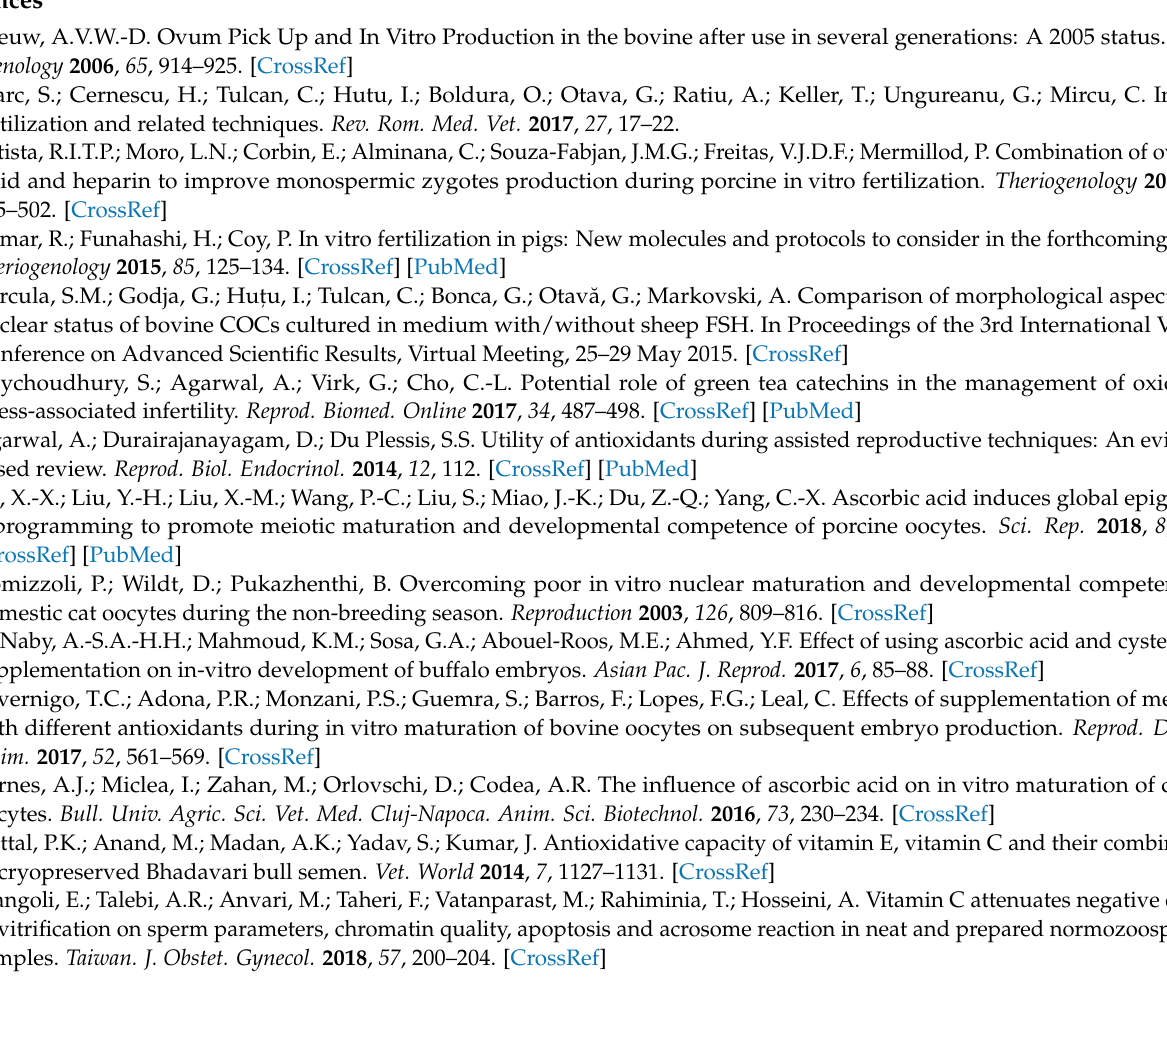
Figure A3. Aspects of porcine oocytes from ascorbic acid group (A) classified according to their morphological aspects before and after IVM. Scale bar represents 100 µm. The scale bar is applicable to all panels (3.2X).